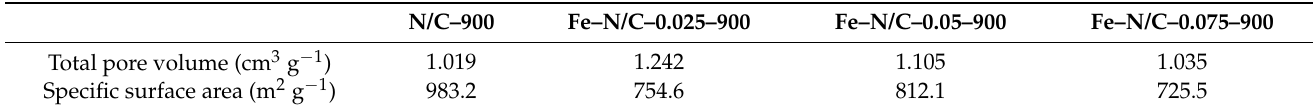
Figure 3. N 2 adsorption and desorption isotherms and pore-size distributions of Fe–N/C-900 with different moral ration of iron. Table 1. BET surface areas and total pore volumes of the as-prepared samples.